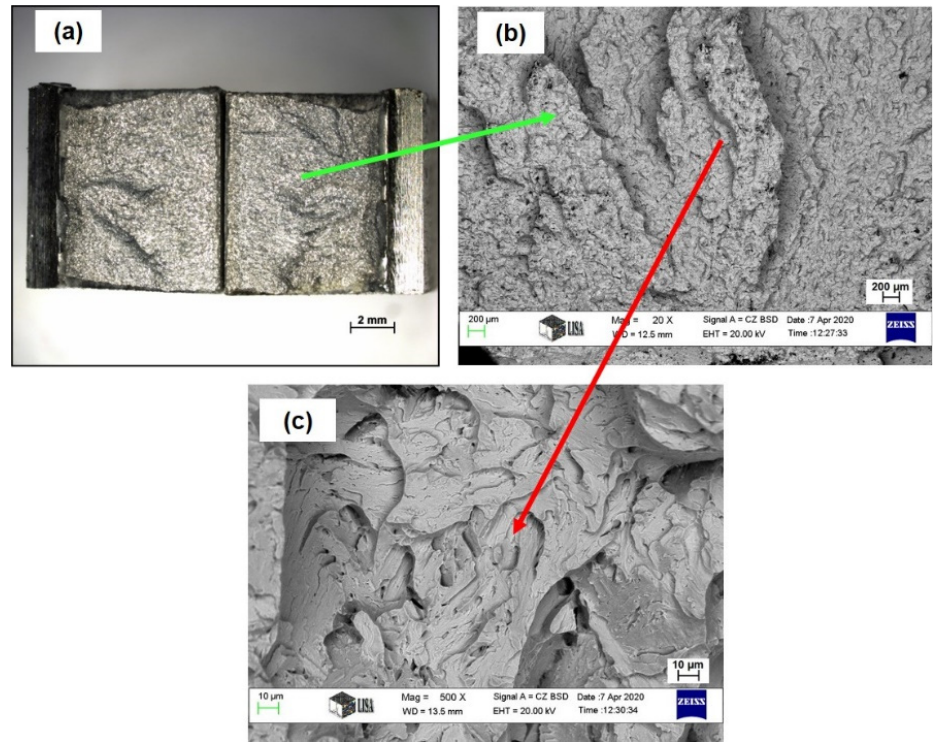
Figure 12. ( a ). HAZ Charpy V specimen at a test temperature of − 40 °C; ( b ) SEM photo of full-fractured surface; ( c ) fractography.